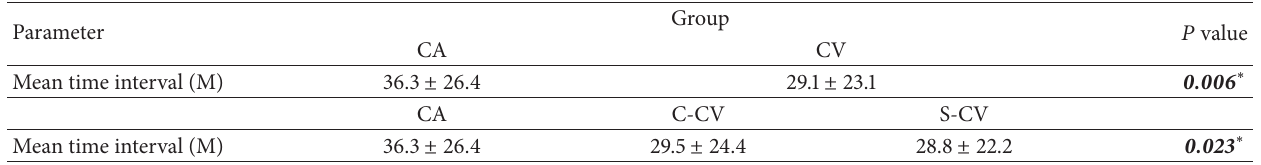
Table 2: Age-matched comparison of the mean time interval from cataract surgery to Nd:YAG capsulotomy. Parameter